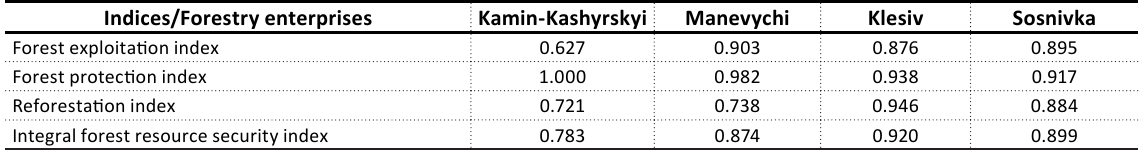
Table 6. Group and integral indices of forest resource security of forestry